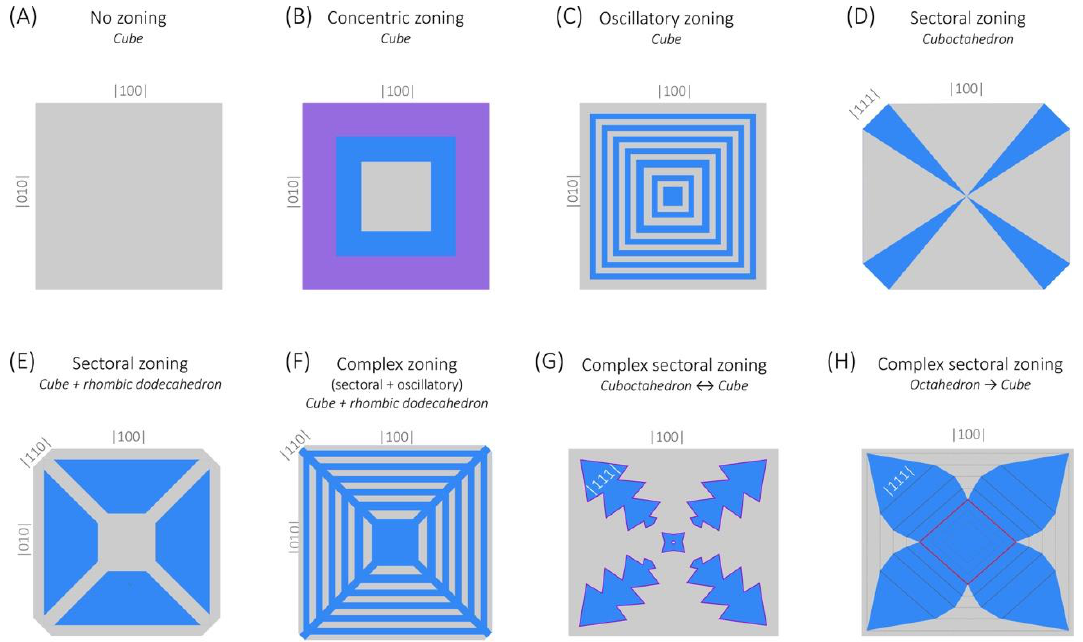
22 of 30 in the Tb/La versus Tb/Ca plot. Both LSB fluorite samples plot close to fluorite measured by Duschl et al. [11] who also investigated fluorite in the LSB. Fluorite samples from the Biwender Vein (Harz) plot in the same area as the generation II ABB fluorite. A remobilization or recrystallization trend is also apparent in the La/Ho versus Y/Ho plot in Figure 10. All fluorite samples show two distinct generations (I and II) that follow a remobilization trend [31]. Y/Ho ratios remain constant whereas La/Ho ratios decrease during remobilization. Schwinn and Markl [36] pointed out that petrographically late fluorite from several of their investigated deposits display geochemical characteristics that reflect new fluid influx rather than remobilization. However, they also acknowledged that variable degrees of supersaturation and fluid/fluorite ratios as well as fluid flux lead to a complex precipitation process that reflects these variable conditions. Hence, a rapid, pulsed crystallization on a micro-scale may display similar features to those seen when new (or later) fluids enter the system. Under certain conditions it is possible to produce two geochemically distinct types of fluorite from one and the same parental fluid within the same crystal (even without remobilization), in